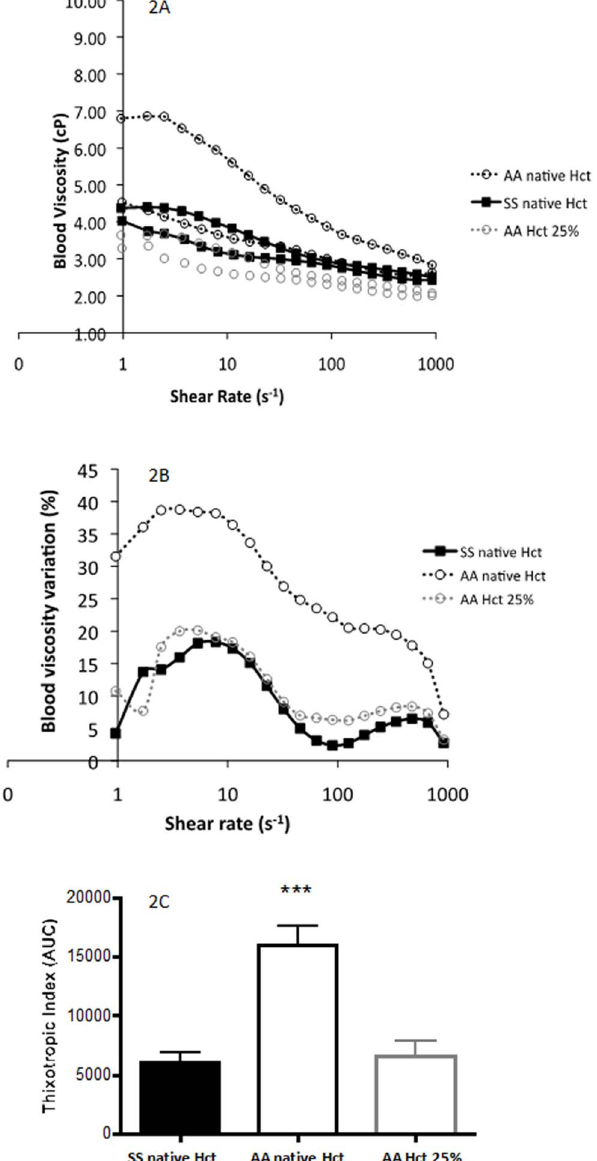
Fig. 2. A–C: Blood viscosity hysteresis loop (2A), differences between the two blood viscosity curves of the loop obtained on Fig. 3A (2B) and blood thixotropic index in patients with sickle cell anaemia (SS) at native haematocrit and healthy individuals (AA) at both native and 25% haematocrit. Significantly from AA at native haematocrit: ***p , 0.001.